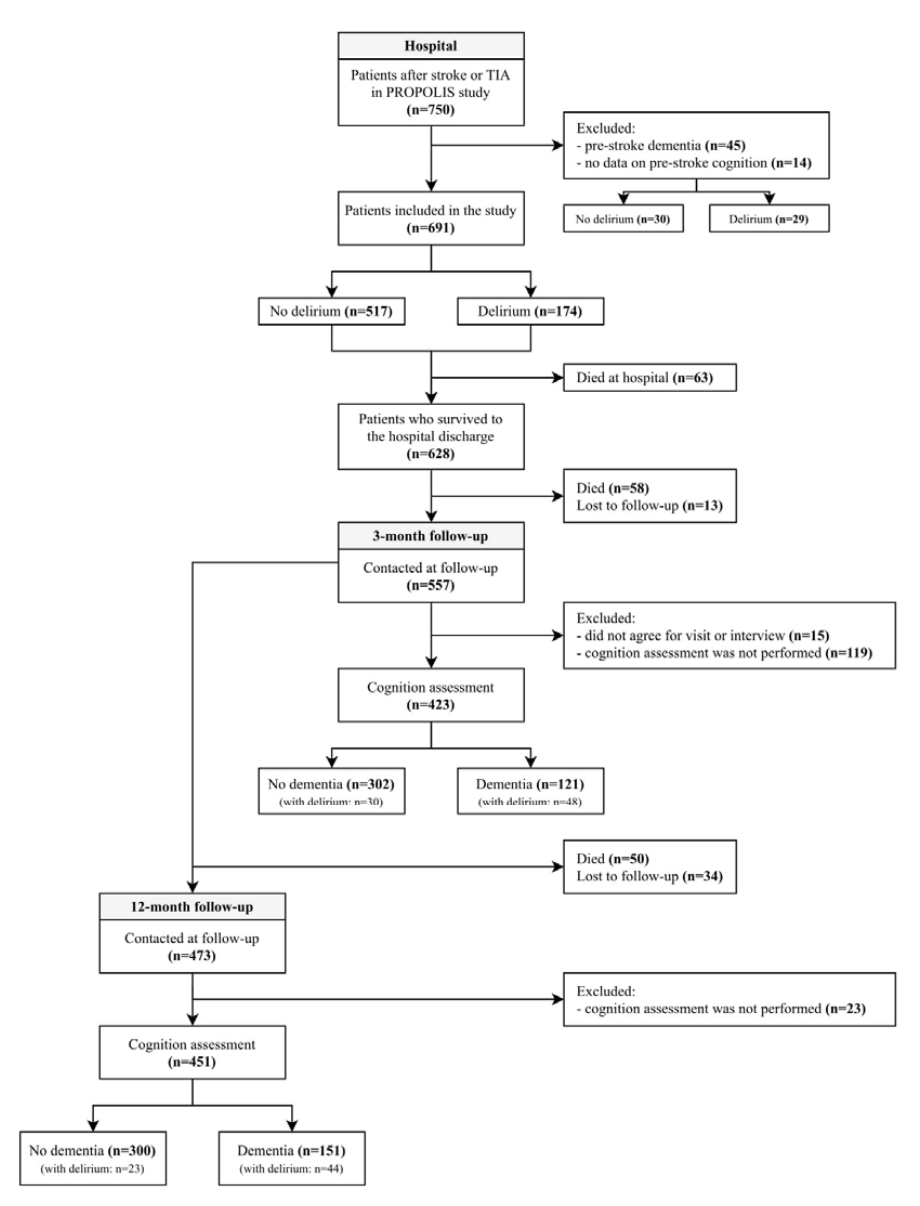
Figure 1. Study flowchart.